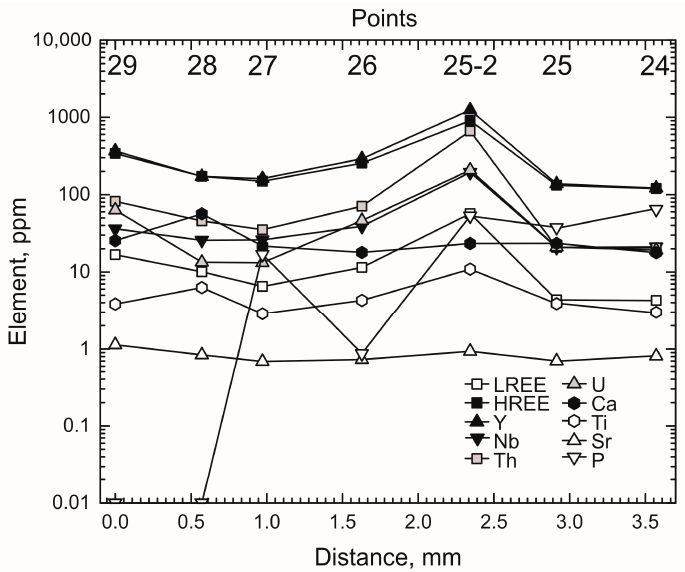
Figure 11. Trace elements zoning of zircon in the growth sector of the face (111) of the dipyramid.